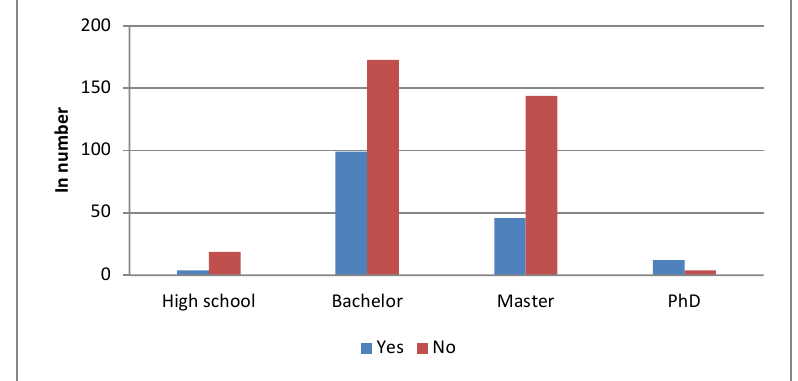
Figure 1: Attendance of trainings according to the education level of managers